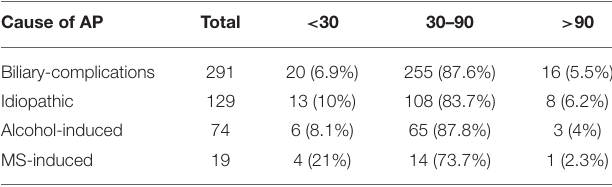
TABLE 2 | The association between major causes of AP and eGFR